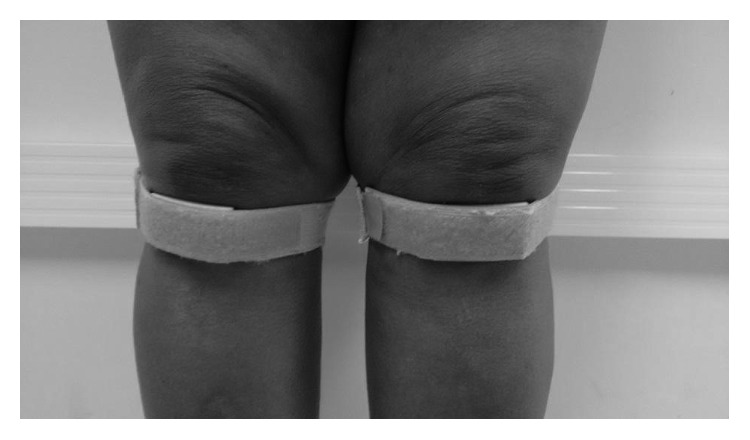
Subpatellar bandage.